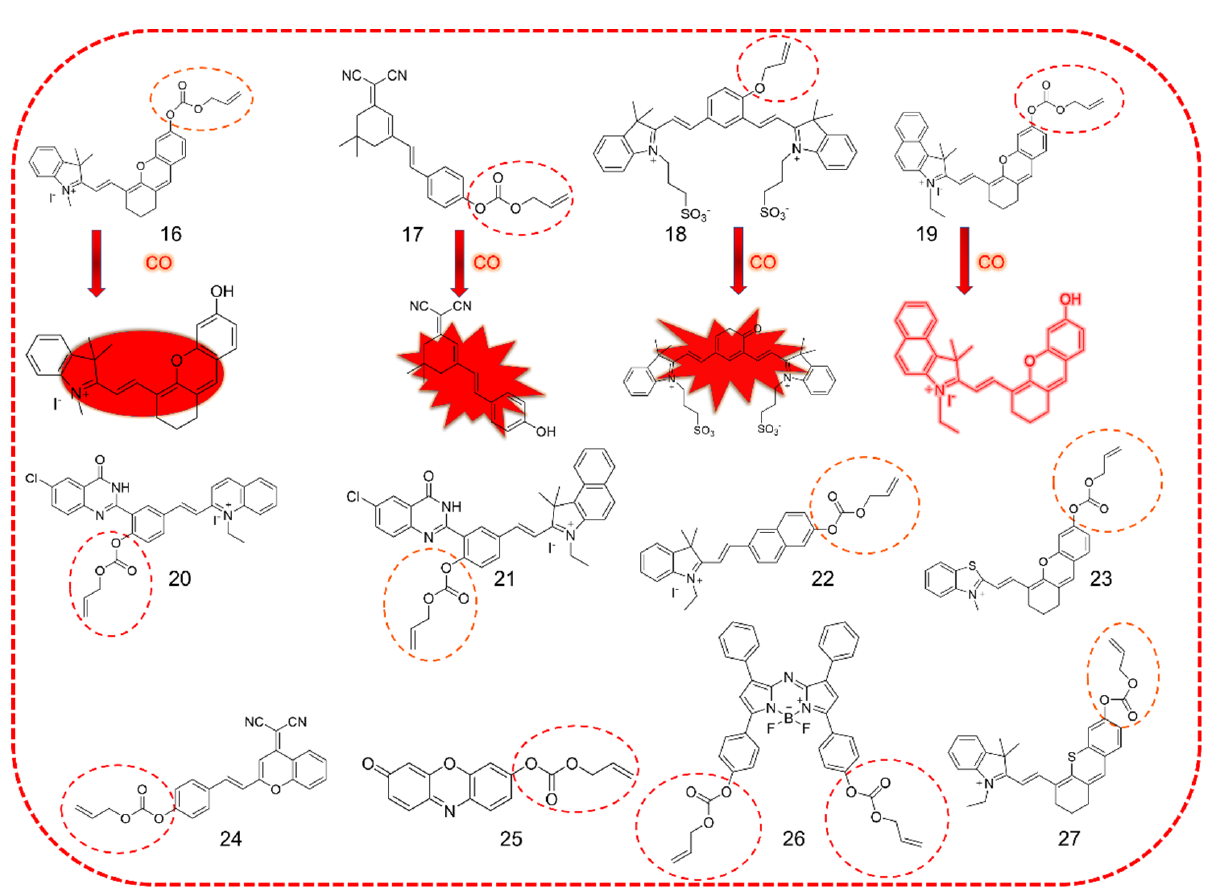
Figure 10. The chemical structures of some NIR CO fluorescent probes constructed with carbonyl propylene ester as the response group.